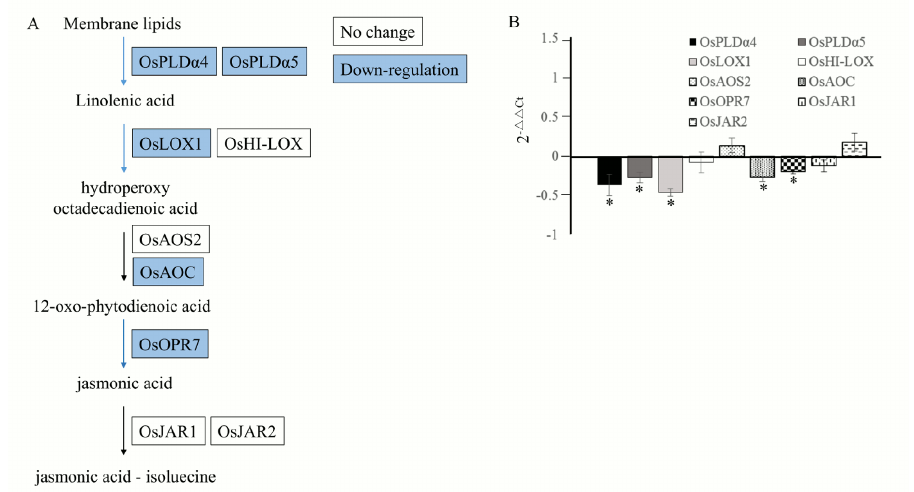
Fig 4. Effects of NDGA on the expression of JA synthesis-related genes. Effects of NDGA on the expression of JA synthesis-related genes ( OsPLD α 4 [LOC_Os06g40170], OsPLD α 5 [LOC_Os06g40180], OsLOX1 [LOC_Os03g49380], OsHI-LOX [LOC_Os08g39840], OsAOS2 [LOC_Os03g12500], OsAOC [LOC_Os03g32314], OsOPR7 [LOC_Os08g35740], OsJAR1 [LOC_Os05g50890] and OsJAR2 [LOC_Os01g12160]) 2 days after treatment at pre-anthesis stage. (A) Scheme of the main steps in the JA synthesis pathway indicating (in colored boxes) the genes that were differently expressed in NDGA treated plants with respect to UTC plants. White indicates genes not significantly different and Blue indicates genes with a significantly lower gene expression. (B) Relative gene expression values setting UTC as 0. Values are Mean ± SE (n = 6). * indicating significance at P (cid:3) 0 . 05